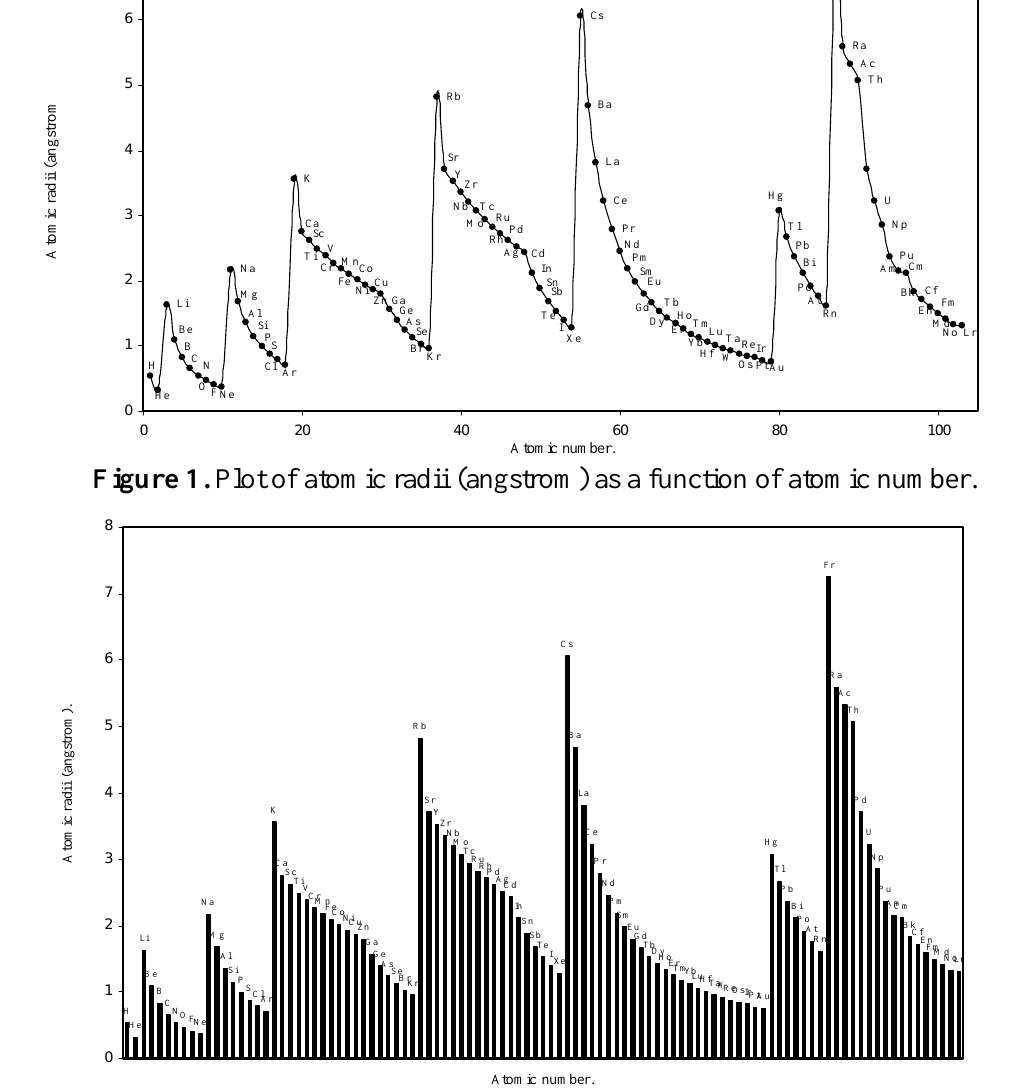
Figure 2. Plot of atomic radii (angstrom) as a function of atomic